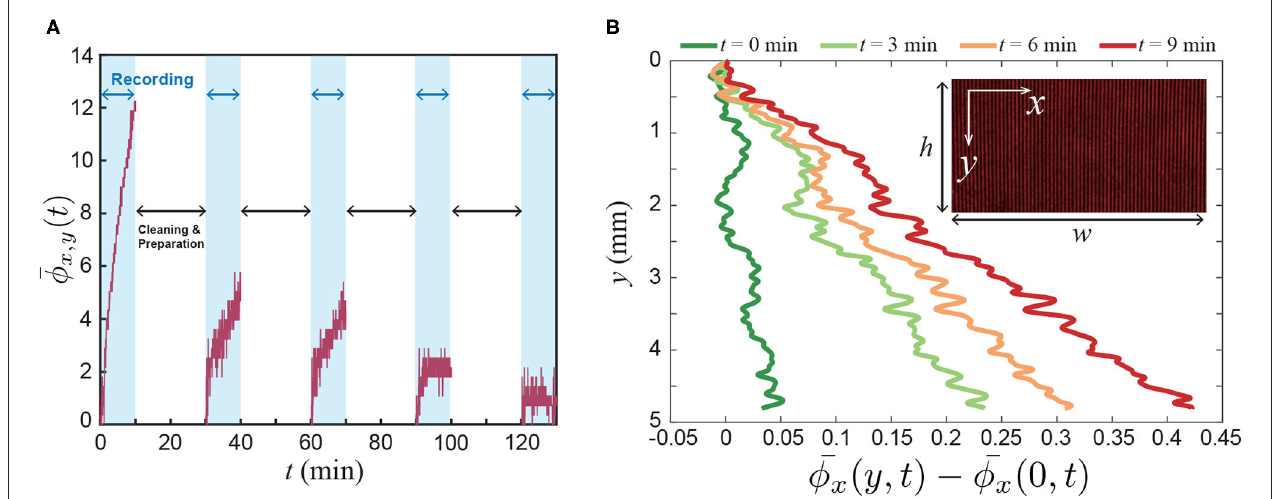
h w 0 R 0 φ ( x , y , t )d x d y , and w and h wh R